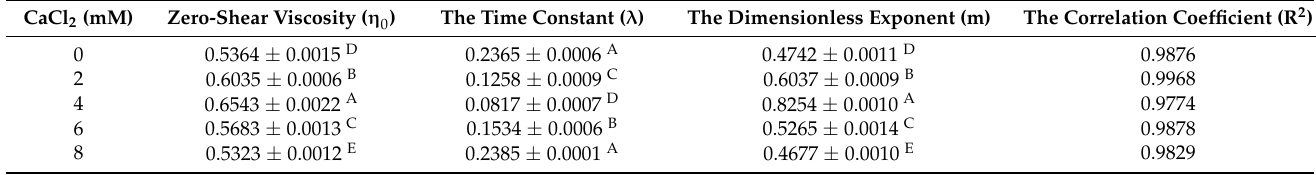
Table 3. Steady shear parameters of the freshly prepared filled hydrogels containing different CaCl 2 levels calculated using the Cross